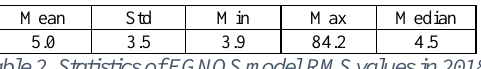
Table 2. Statistics of EGNOS model RMS values in 2018. Values are in TECU.